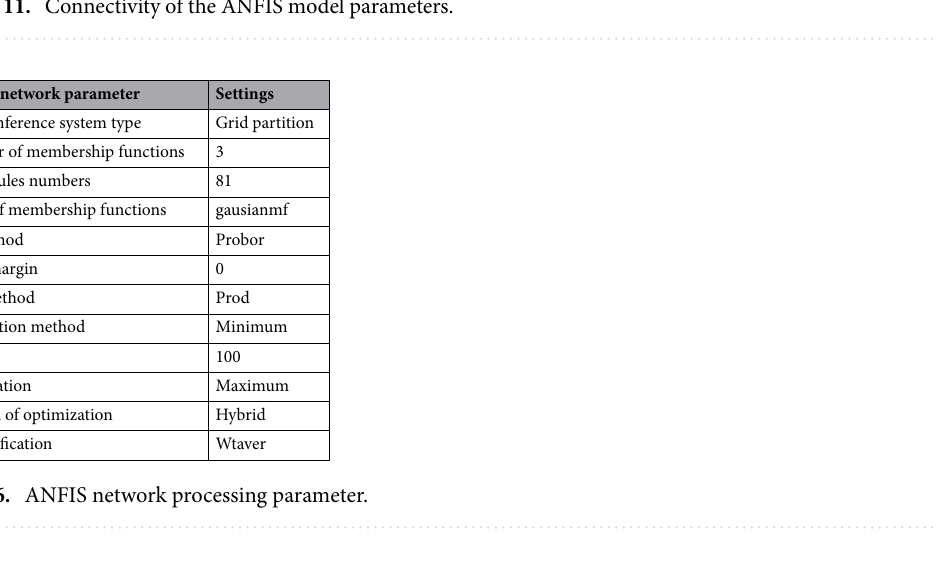
Figure 11. Connectivity of the ANFIS model parameters.